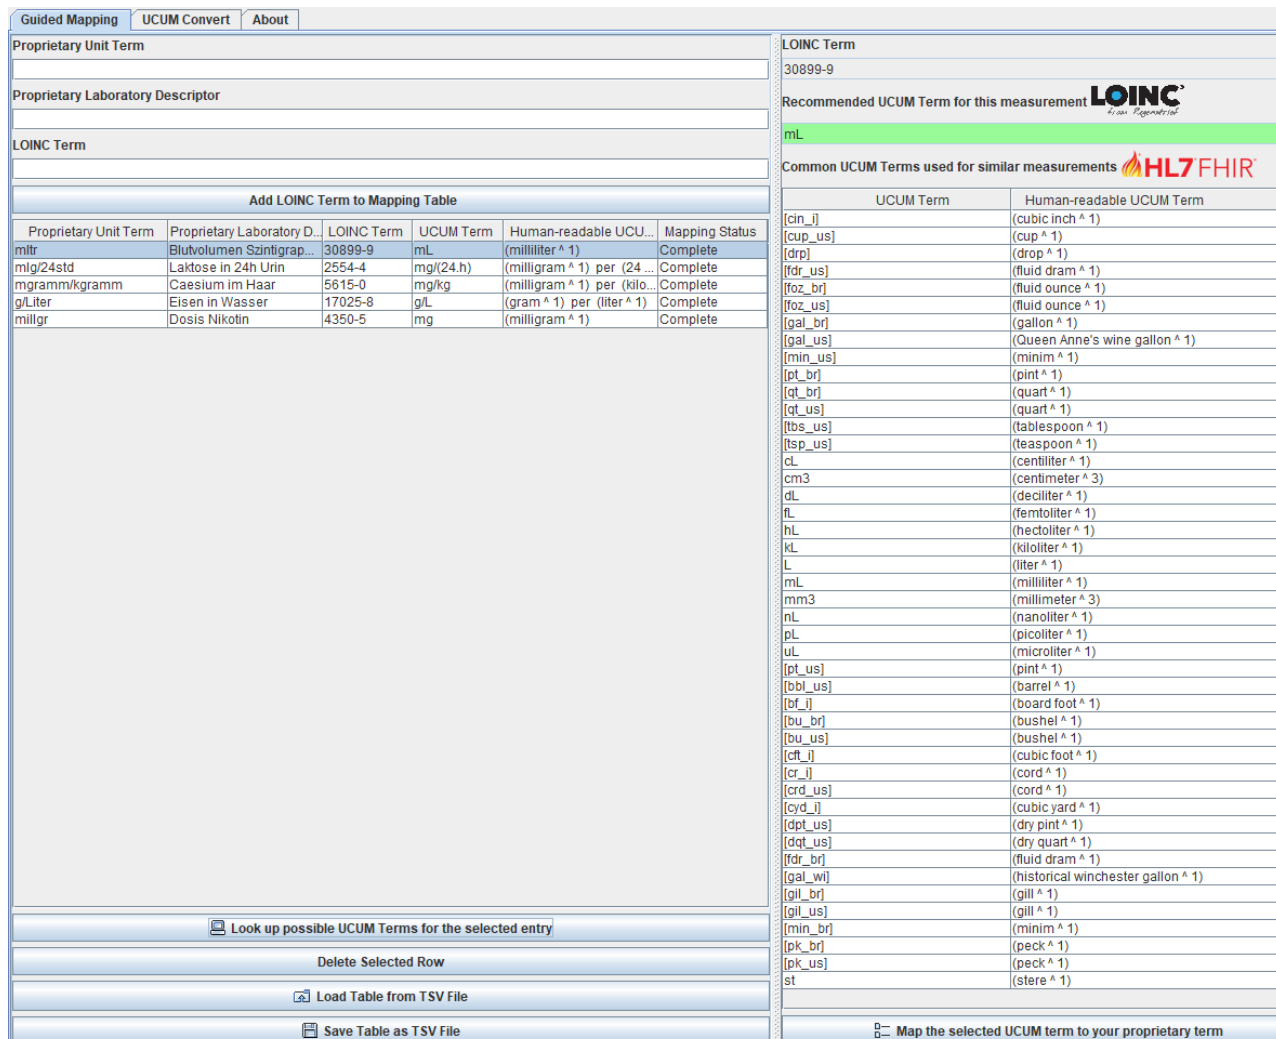
Figure 6. The left side of the mapping window deals with the user’s instance data while the right one is based on the formalization we